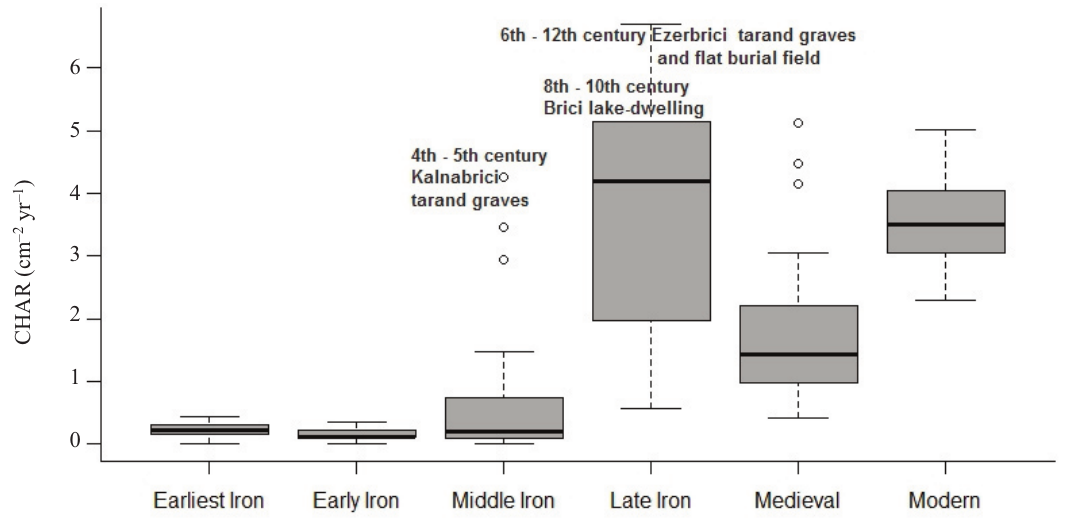
Fig. 6. Bricu II CHAR data (particles cm –2 yr –1 ) reflecting fire during the Earliest Iron Age (500 BCE–1 CE), Early Iron Age (1–400 CE), Middle Iron Age (400–800 CE), Late Iron Age (800–1200 CE), Medieval period (1200–1550 CE) and Modern period (Post­ Medieval and Modern periods combined, 1550